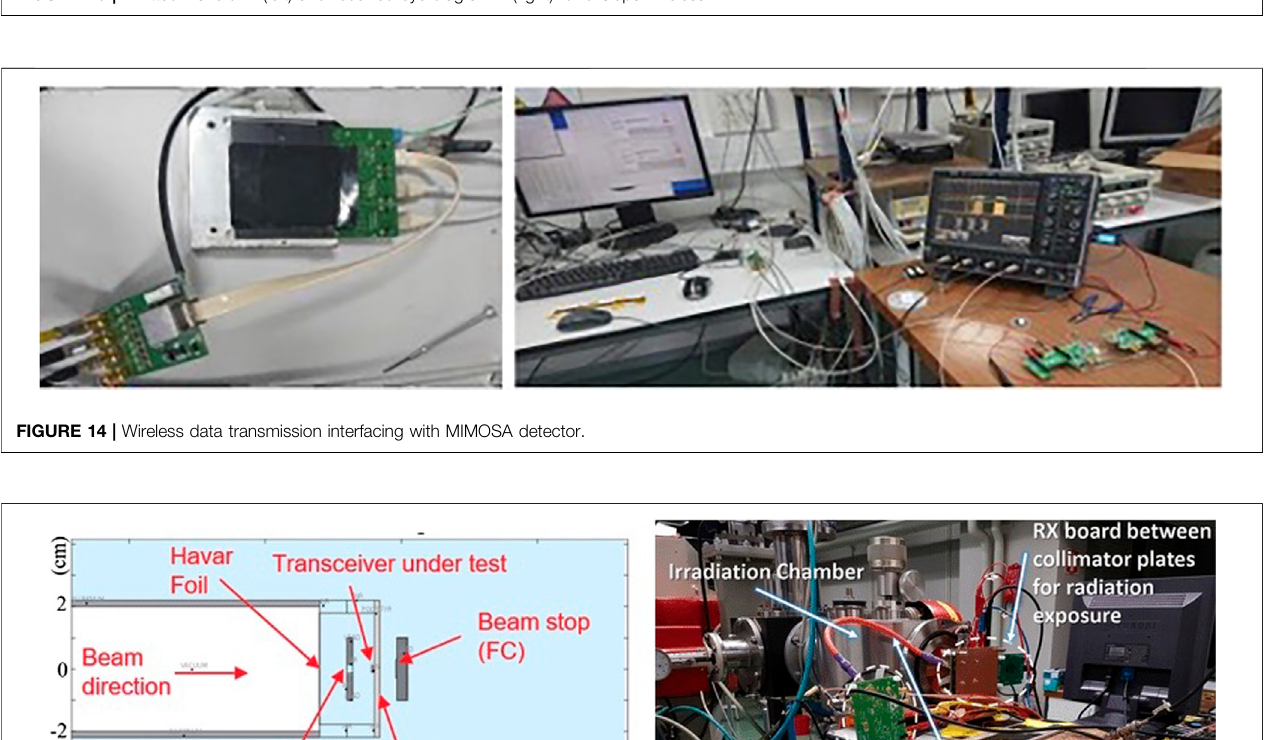
FIGURE 13 | Emitted waveform (left) and received eye diagramm (right) for 5 Gbps wireless link.